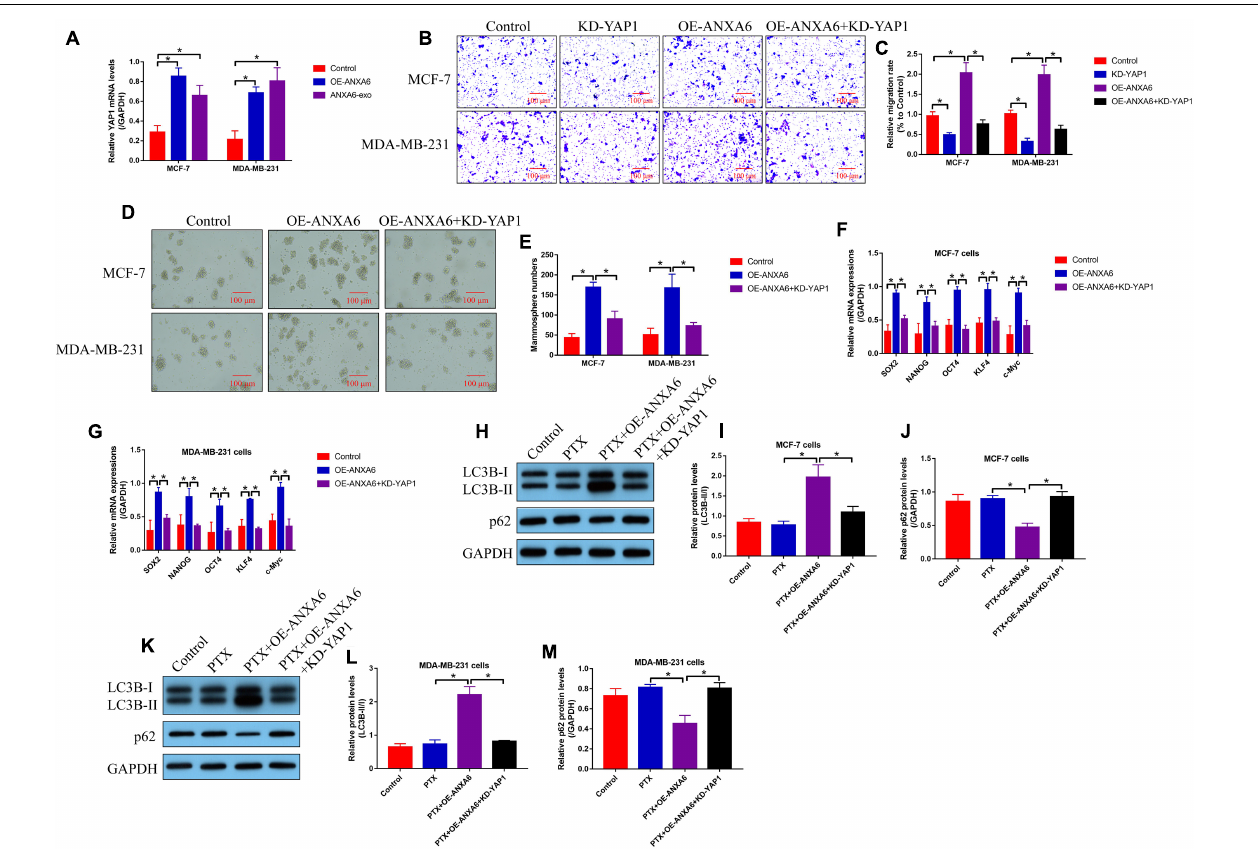
FIGURE 5 | ANXA6 overexpression promoted cell migration, stemness, and autophagy in PS-BC cells through upregulating YAP1. (A) Real-time qPCR analysis validated that ANXA6 positively regulated YAP1 mRNA levels in PS-BC cells. (B,C) Transwell assay was used to examine cell migration abilities. Cancer stem cell properties in BC cells were evaluated by (D,E) spheroid formation assay and (F,G) real-time qPCR analysis. (H–M) The regulating effects of ANXA6 and YAP1 on cell autophagy were investigated by performing Western blot analysis. A single experiment had three repetitions, and * p < 0.05 was regarded as statistical significance.